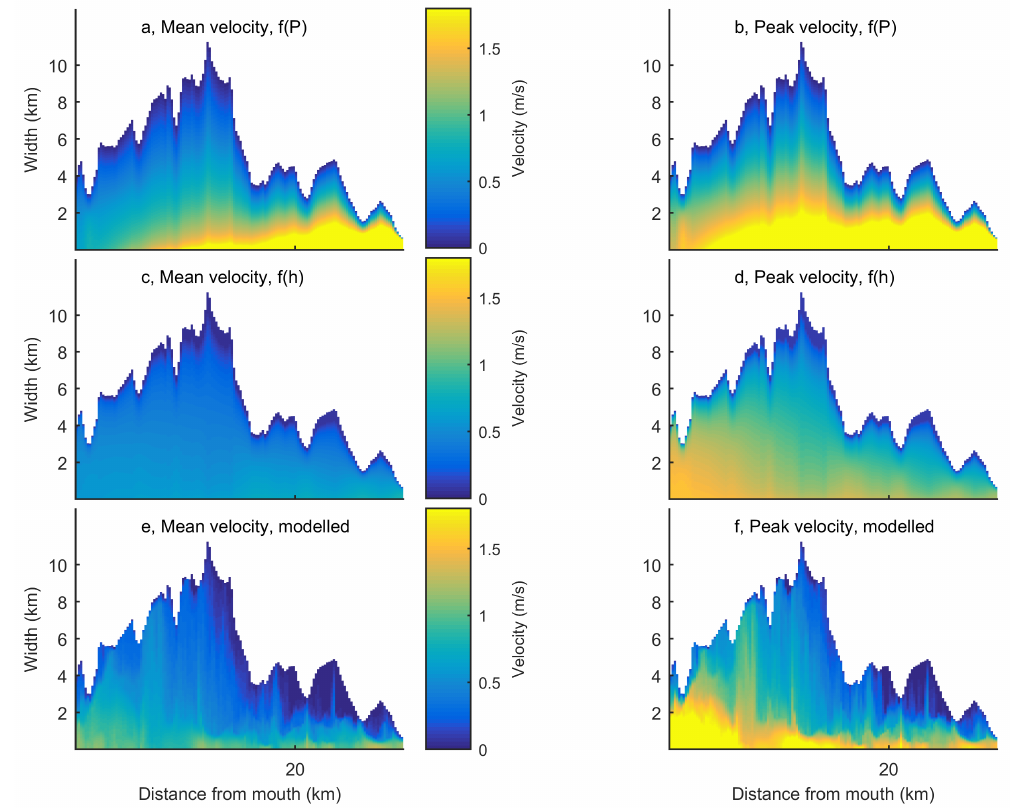
Figure 9. Mean velocity over a tidal cycle (left) and peak tidal flow velocity (right) as a function of local tidal prism ( a , b ), bed elevation ( c , d ) and numerically modelled values ( e , f ) for the Columbia River.